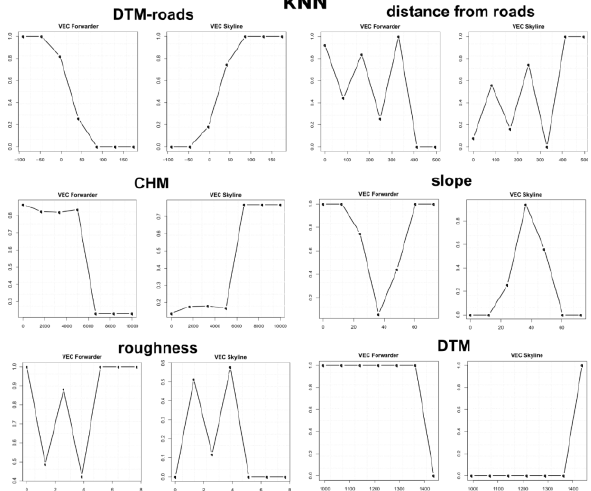
Figure 8. Inputs sensitivity analysis for the two classes of the KNN classification.